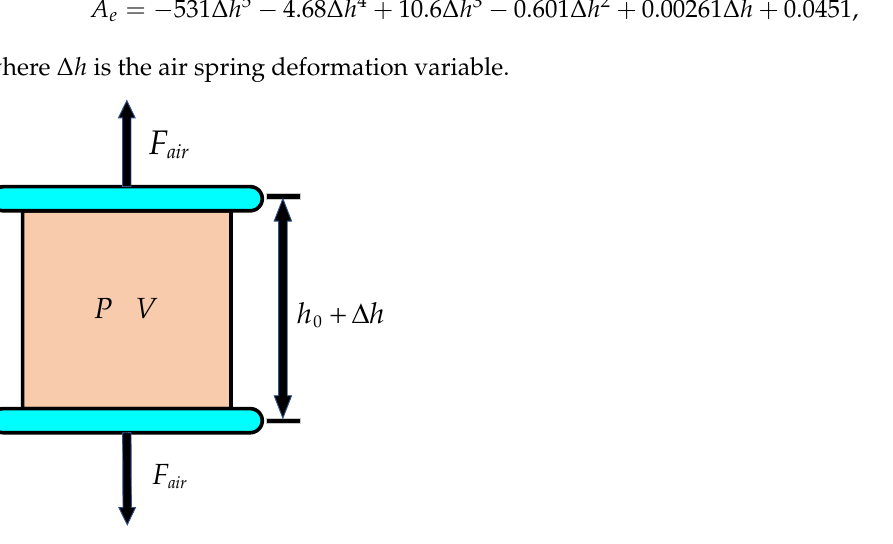
Figure 3. The simplified physical model of the air spring.